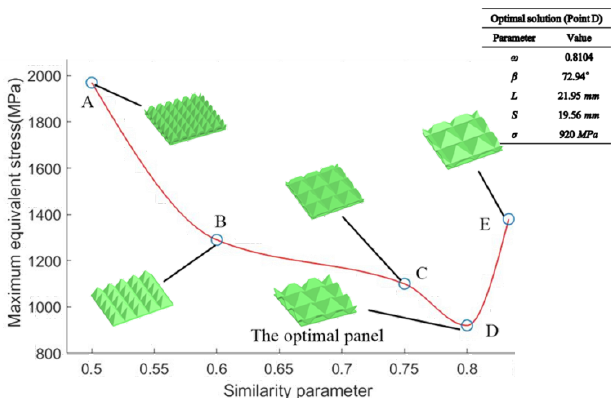
Figure 21. Comparison with the optimized panel.